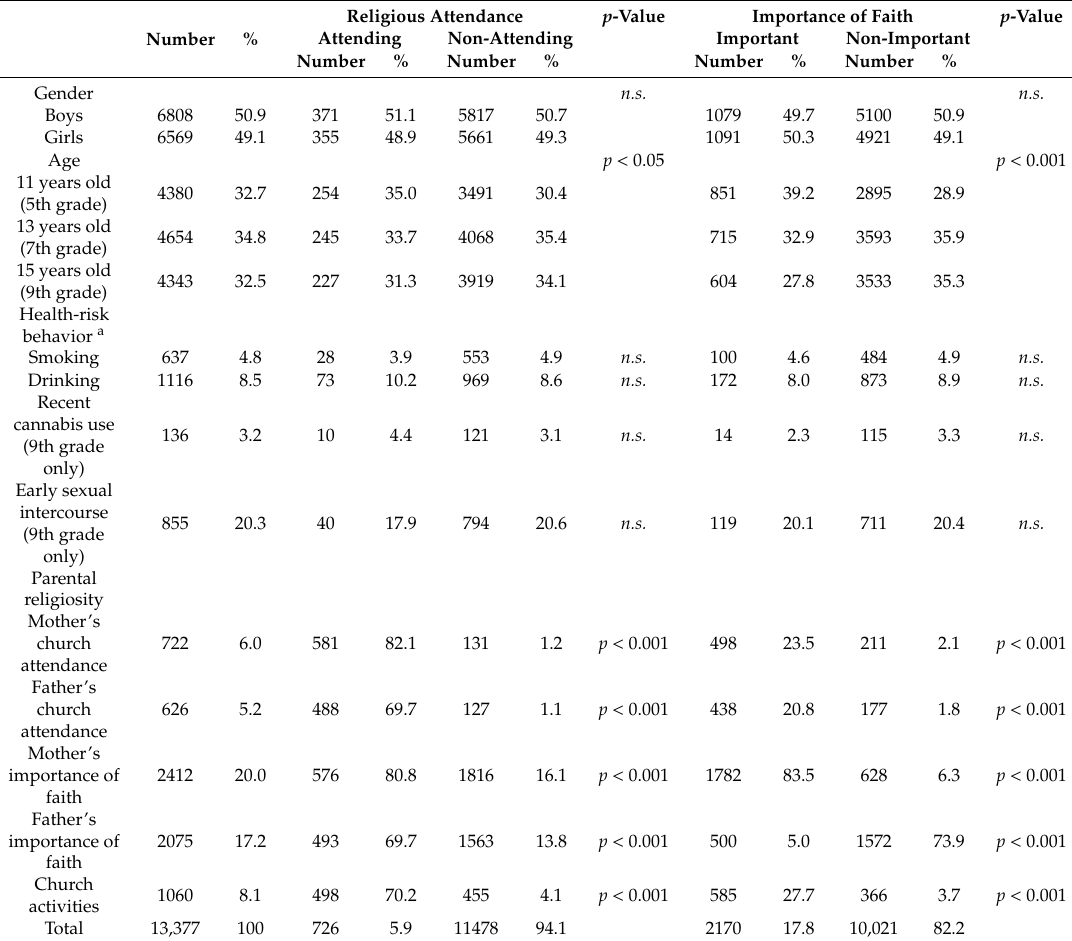
Table 1. Sample characteristics by religious attendance and importance of